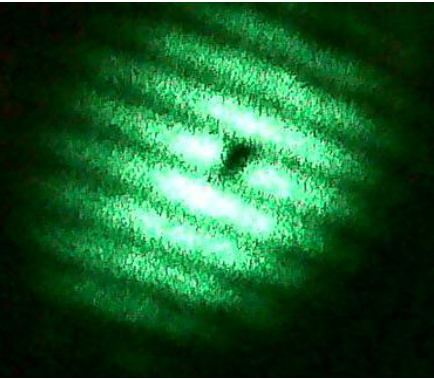
Figure 14. Detector output variation during heating, 0–1000 s (Ti: Sapphire laser on) and cooling, 1000–2000 s (Ti: Sapphire laser off)